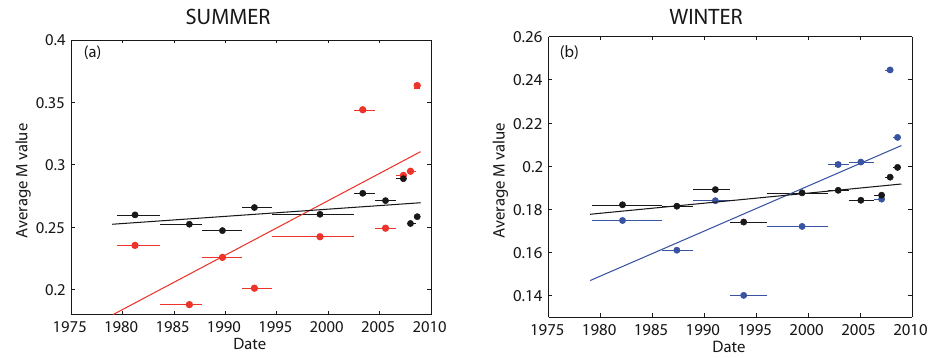
Fig. 14. Mean time series M(t) (a) in summer (red) and (b) in winter (blue), as in Fig. 10 and M 0 (t) (black lines), resulting from the null hypothesis. The best linear fits are also plotted, showing that changes in spatial sampling only account for a small fraction of the observed